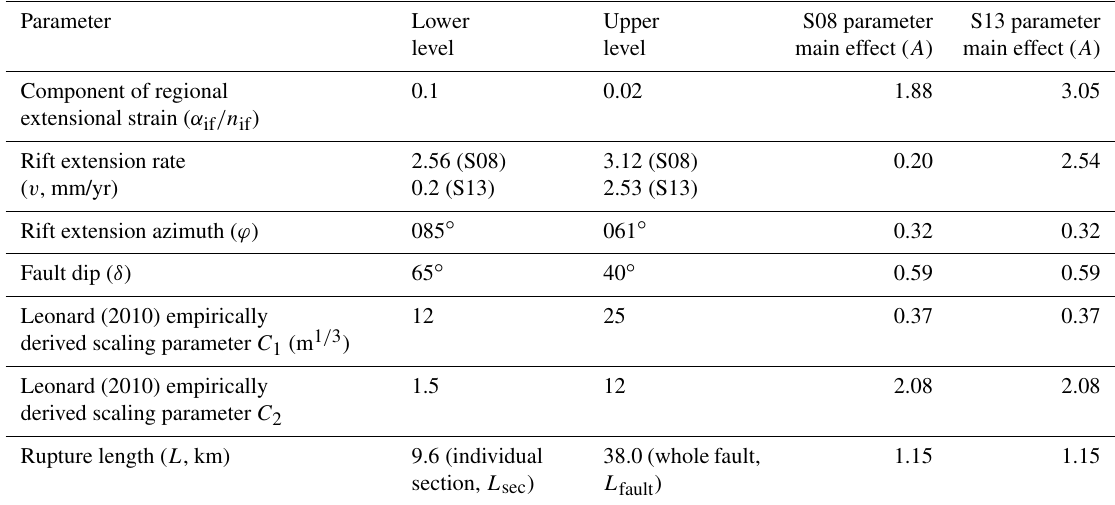
Table 5. Parameters and their associated upper and lower levels used in the sensitivity analysis for recurrence interval ( R ) calculations for the Chingale Step fault central section using the Stamps et al. (2008) (S08) and Saria et al. (2013) (S13) Nubia–Rovuma Euler poles (Fig. A1). The main effect of each parameter ( A ) for each geodetic model is then also reported. See Appendix A for full details of this